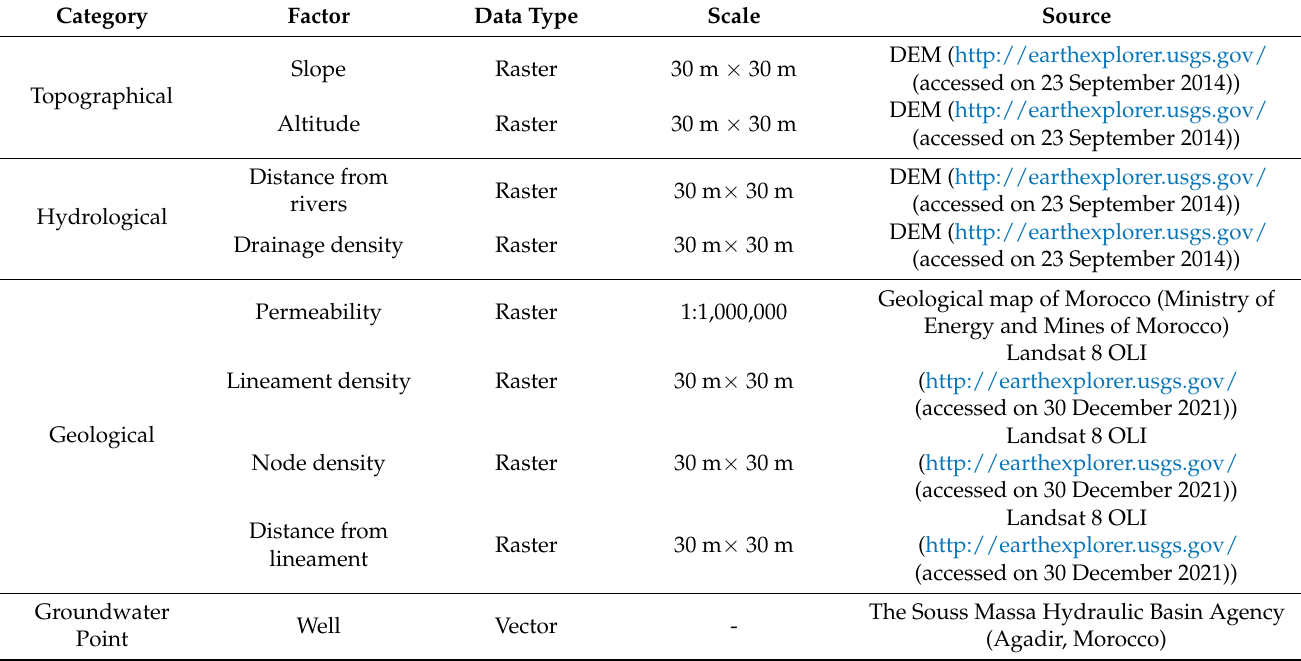
Table 1. Database of the Tissent